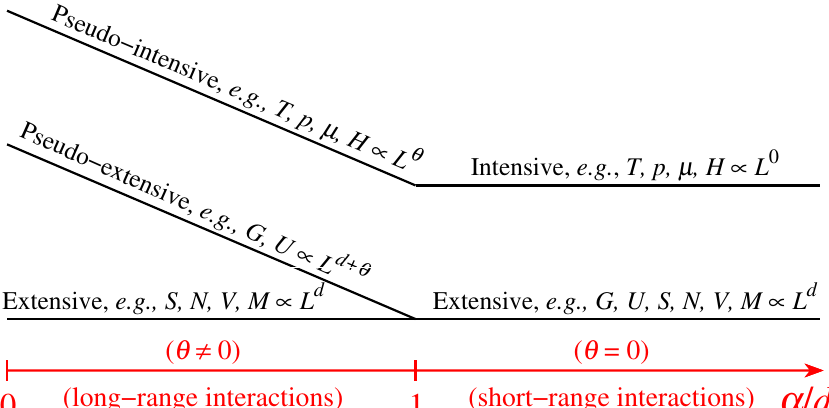
Figure 3. Representation of the different scaling regimes for classical d -dimensional systems. For attractive long-range interactions (i.e., 0 ≤ α / d ≤ 1, α characterizing the interaction range in a potential with the form 1/ r α ; for example, Newtonian gravitation corresponds to ( d , α ) = ( 3,1 ) ) one can distinguish three classes of thermodynamic variables, namely: those, scaling with L θ , named “pseudointensive” ( L is a characteristic linear length, θ depends on the class of systems); those, scaling with L d + θ with θ = d − α , the pseudoextensive ones (the energies); and those, scaling with L d (which are always extensive). For short-range interactions (i.e., α > d ) one has θ = 0 and the energies recover their standard L d extensive scaling, falling within the same class of S , N , V , M , etc. (see text for notations of the thermodynamic variables), whereas the previous pseudointensive variables become truly intensive ones (independent of L ); this is the region, with only two classes of variables, that is covered by the traditional textbooks on thermodynamics. For more details, see